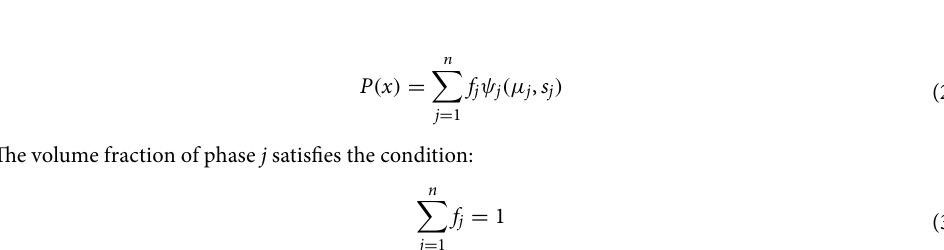
Figure 4. Indents in ITZ